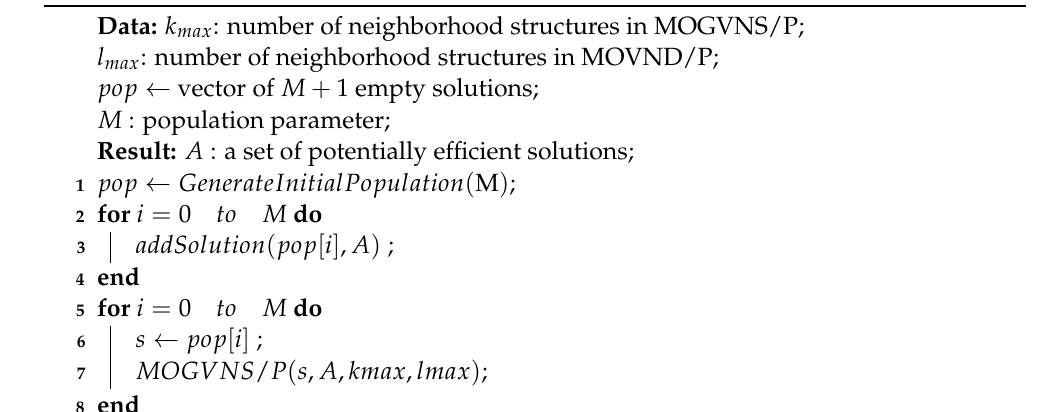
Algorithm 6: Multi-objective GVNS based on Pareto Dominance and Decompo- sition (MOGVNS/CDP).